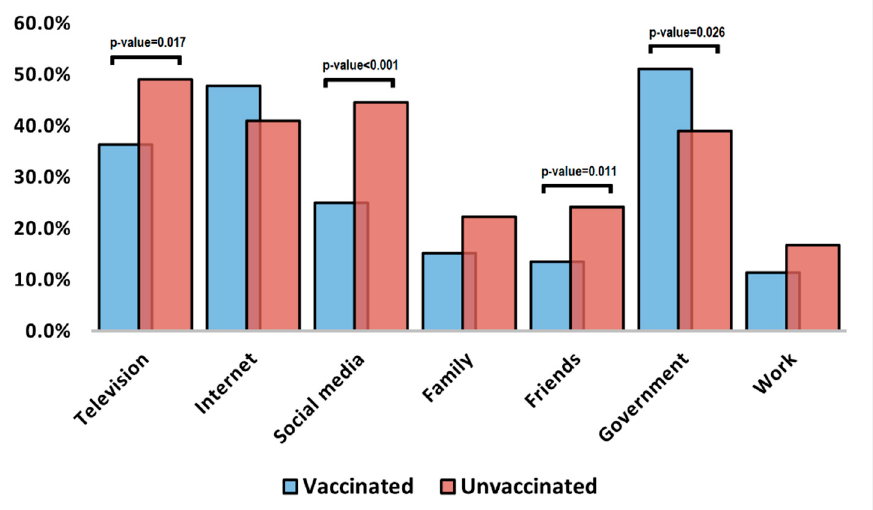
Figure 1. Influencing factors for COVID-19 vaccination.